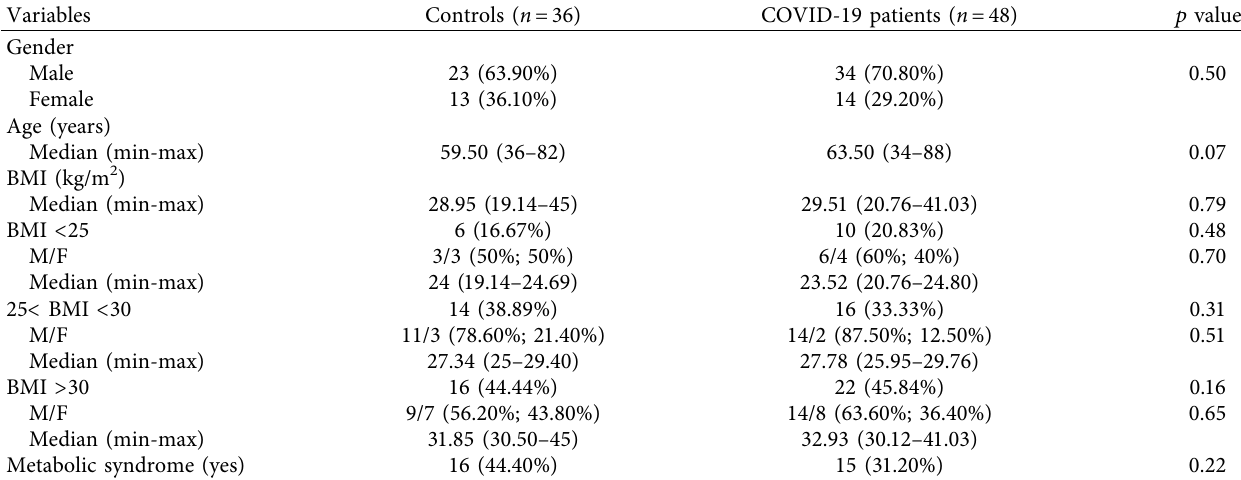
Table 1: Patient general